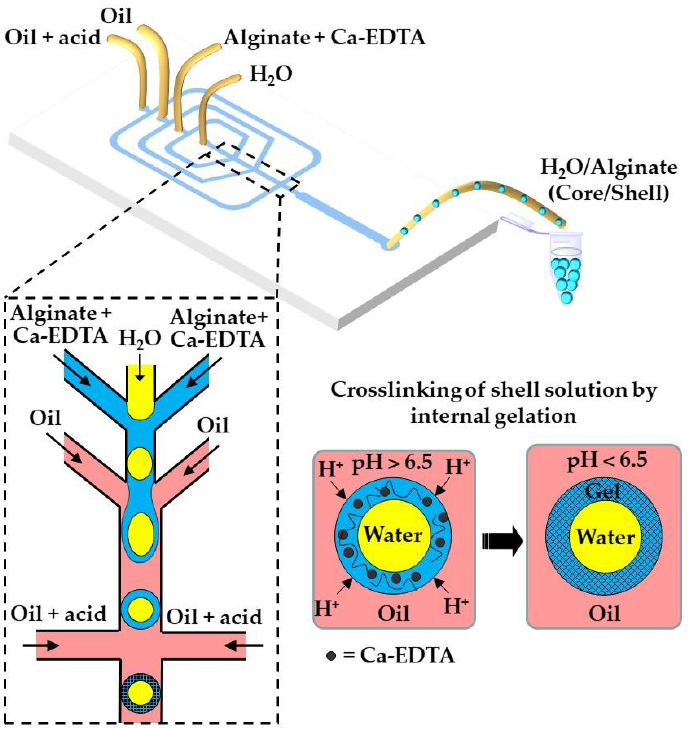
Figure 29. Fabrication of core−shell microgels consisting of an aqueous core and an alginate shell via W/W/O double emulsion template droplets. The alginate in the shell is crosslinked by the in situ triggered release of Ca 2+ from Ca-EDTA. Different types of liver cells can be encapsulated in the core and shell regions to create an artificial liver on a microgel [117]. Hollow microgel capsules can be generated by the internal gelation of core−shell droplets within an O/W/O double emulsion [116,120]. In this approach, usually Ca-EDTA or CaCO 3 is added to the alginate solution in the middle phase, and crosslinking is initi- ated on-chip by organic acid dissolved in the outer oil phase [120] or off-chip by collecting the formed double emulsion droplets in an acidified oil phase [116]. Alternatively, a photo-acid generator (PAG) can be added to the middle phase to trigger crosslinking by UV light. The fabrication of capsules through the UV irradiation of template droplets con- taining a mixture of alginate, PAG, and CaCO 3 in the middle phase is shown in Figure 30 (Table S8).